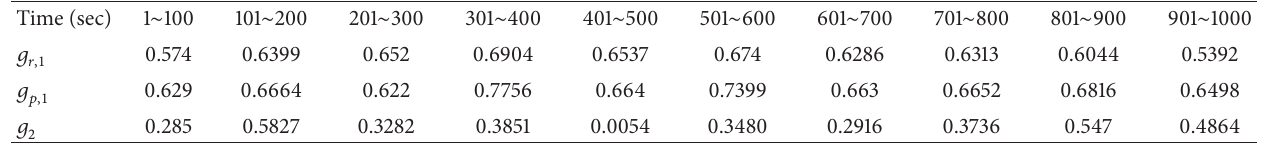
Table 2: Estimated gain parameters for GA based adaptive 𝛼 - 𝛽 - 𝛾 filter.